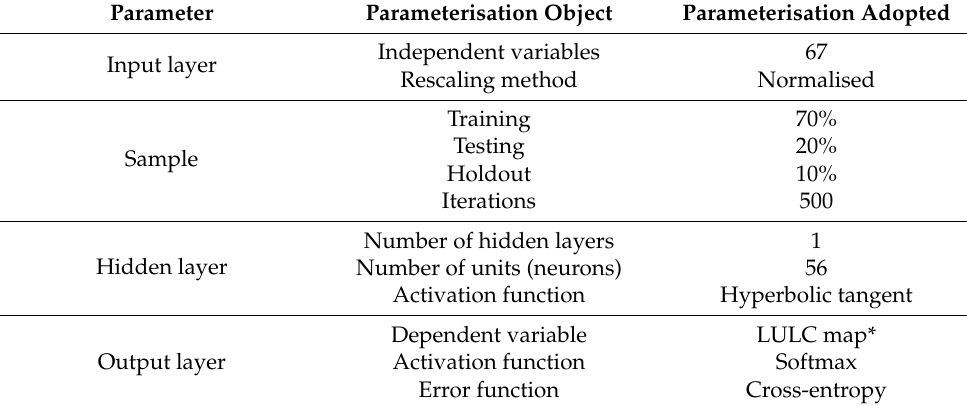
Table 7. ANN1 model parameters used to simulate the predictive